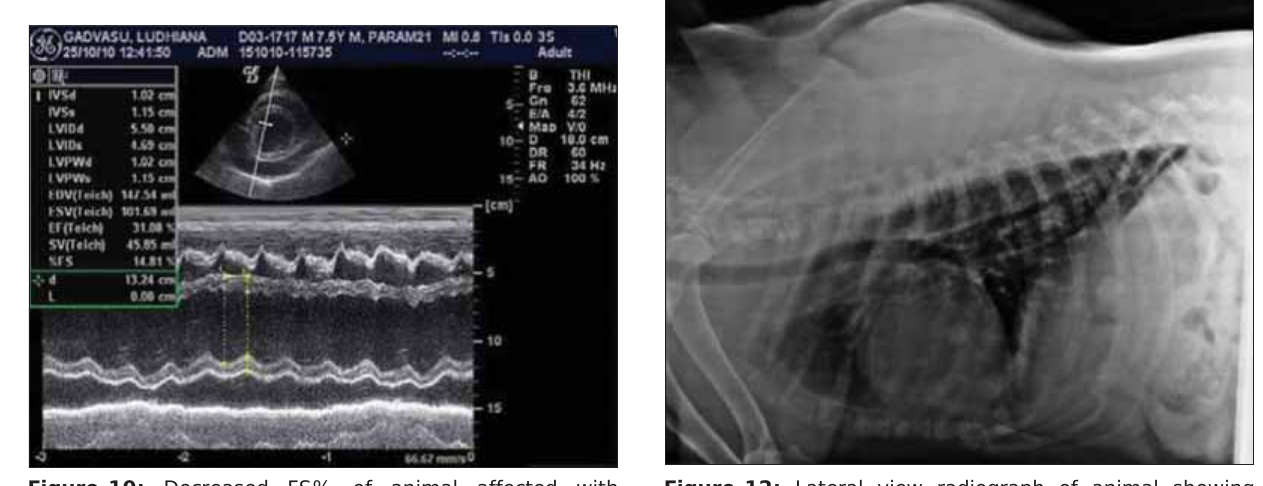
Figure-12: Lateral view radiograph of animal showing